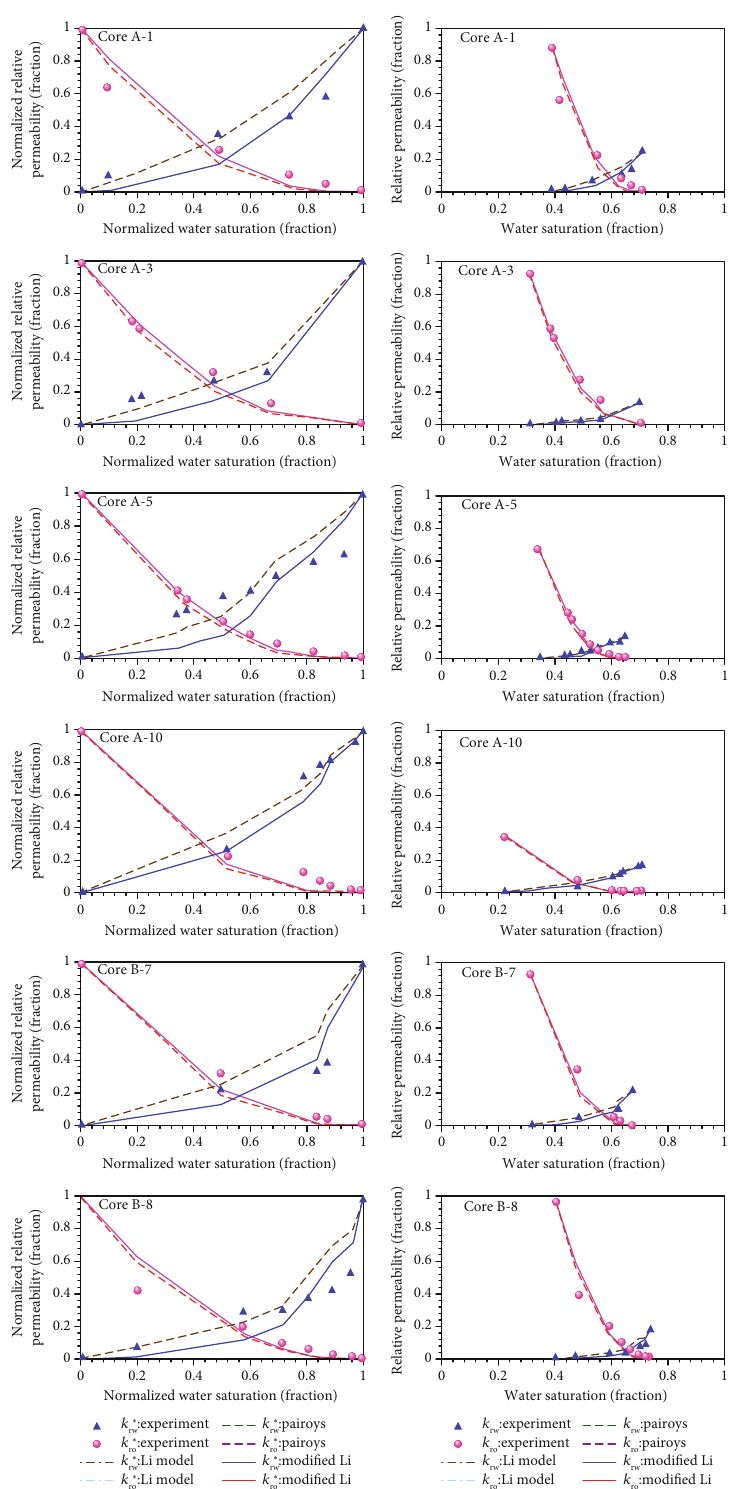
Figure 8: Comparison of relative permeability curves in shaly sand